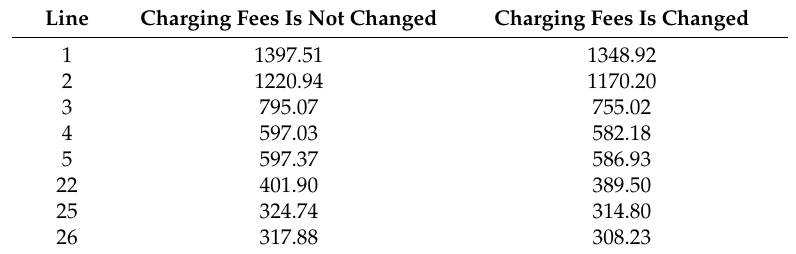
Table 5. Standard deviation of active power of a line before and after adjustment for charging fees. Line